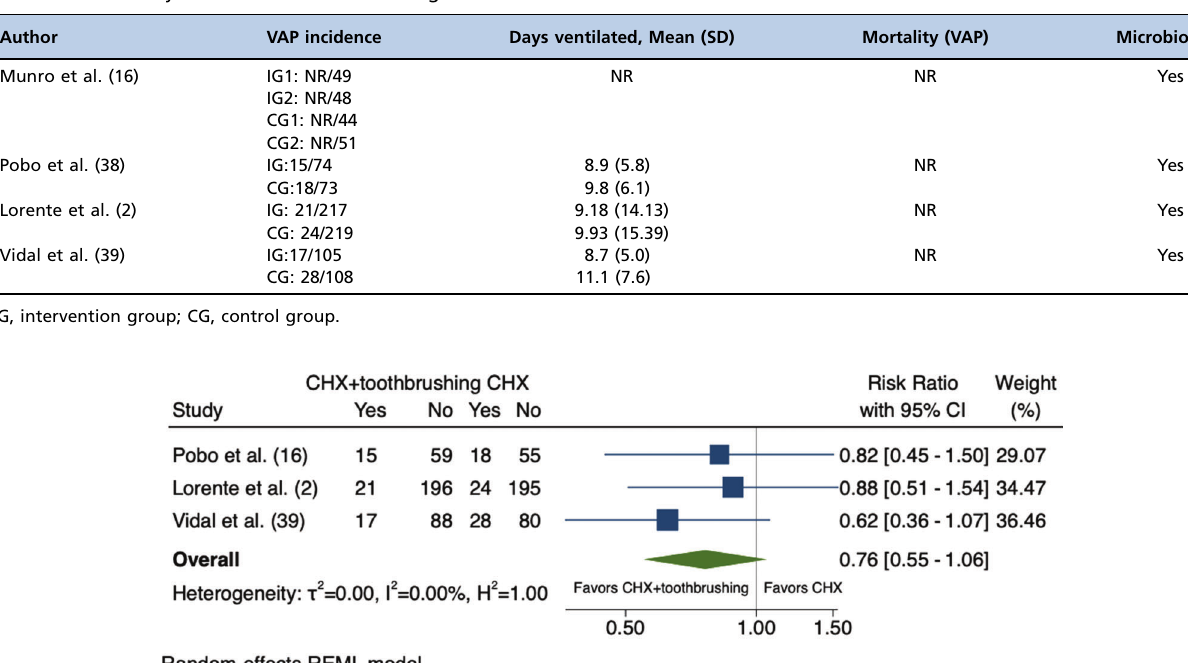
Table 4 - Summary of the outcomes of the eligible studies.